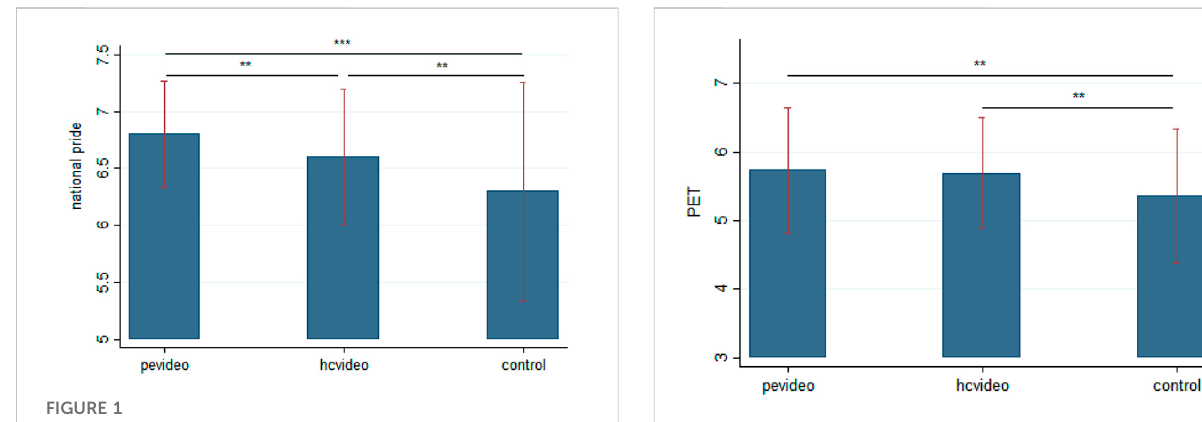
FIGURE 2 Participants ’ PET in the three priming groups. Note: ** p <